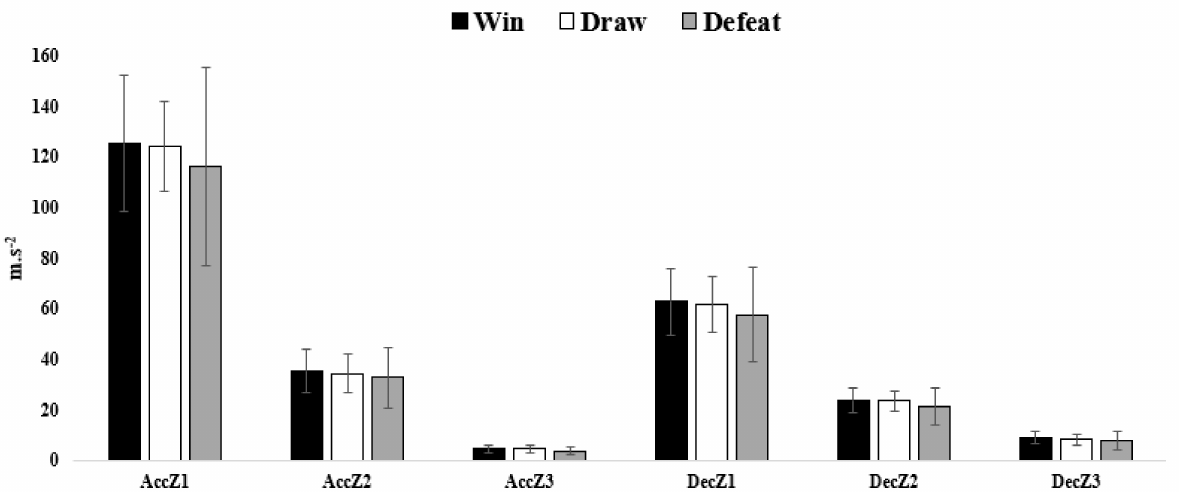
Figure 2. Comparisons based on the match result for accelerations and decelerations. AccZ1, Accelerations in zone 1 (<2 m · s − 2 ); AccZ2, accelerations in zone 2 (2 to 4 m · s − 2 ); AccZ3, accelerations in zone 3 (>4 m · s − 2 ); DecZ1, decelerations in zone 1 (> − 2 m · s − 2 ); DecZ2, decelerations in zone 2 ( − 2 to − 4 m · s − 2 ); DecZ3, decelerations in zone 3 (< − 4 m · s − 2